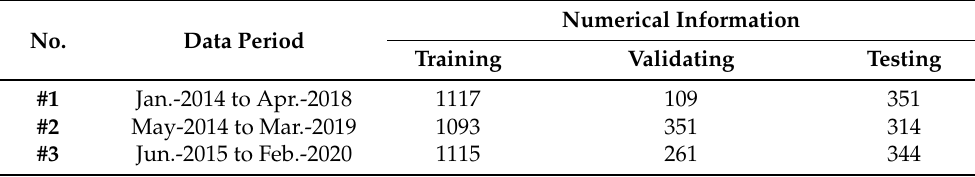
Table 3. Numerical data summary showing the total number of records (days).